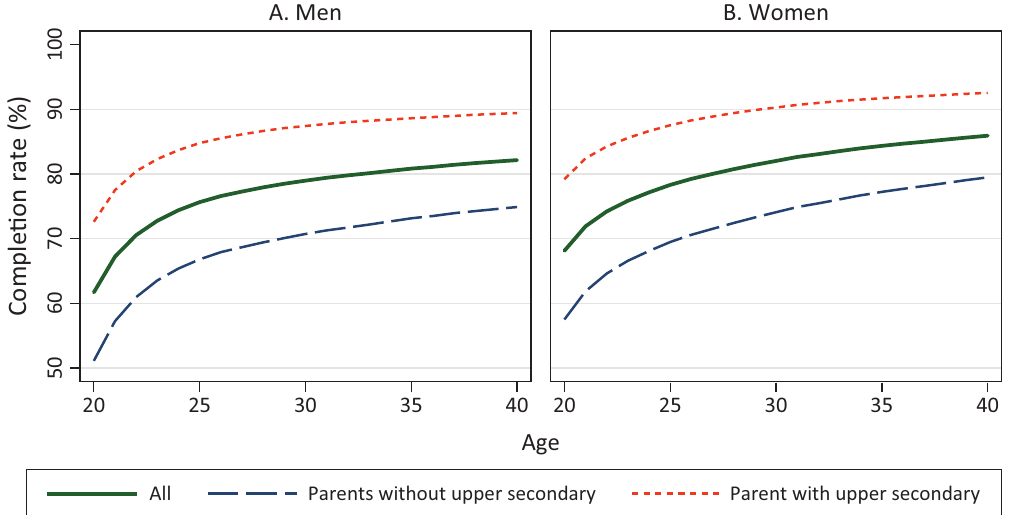
Figure 1. Completion of upper secondary education by age, gender, and parental education. Notes: Samples consist of 1973–1977 birth cohorts, with Norwegian-born parents and valid education data, and present in the country. Observation counts are 129,712 men and 124,109 women at age 20, declining to 125,207 men and 121,127 women at age 40. Data ex- tracts are further described in Section 4. Completion rates for men are 61.7% (age 20), 75.7% (25), and 82.2% (40), and for women 68.1% (age 20), 78.3% (25), and 85.9% (40). Parental education is observed at age 15. The two parental education samples are of comparable size (51% had two parents without completed upper secondary